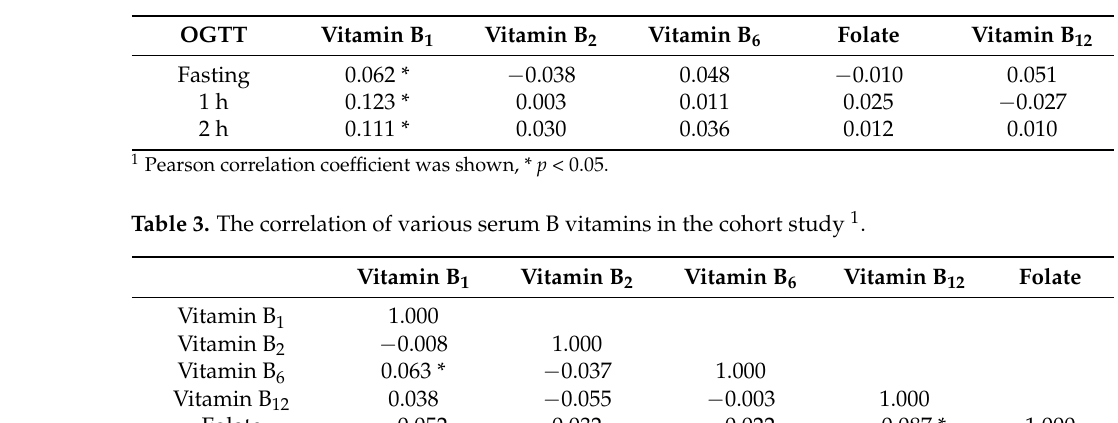
Figure 1. Scatter plot of serum vitamin B 1 and glucose levels at OGTT: ( a ) fasting glucose; ( b ) 1 h glucose; ( c ) 2 h glucose. The lines indicate the straight-line correlations, and the grey–shaded areas represent 95% confidence intervals (CI). Table 2. The correlation of serum B vitamins and glucose levels in the cohort study 1 .